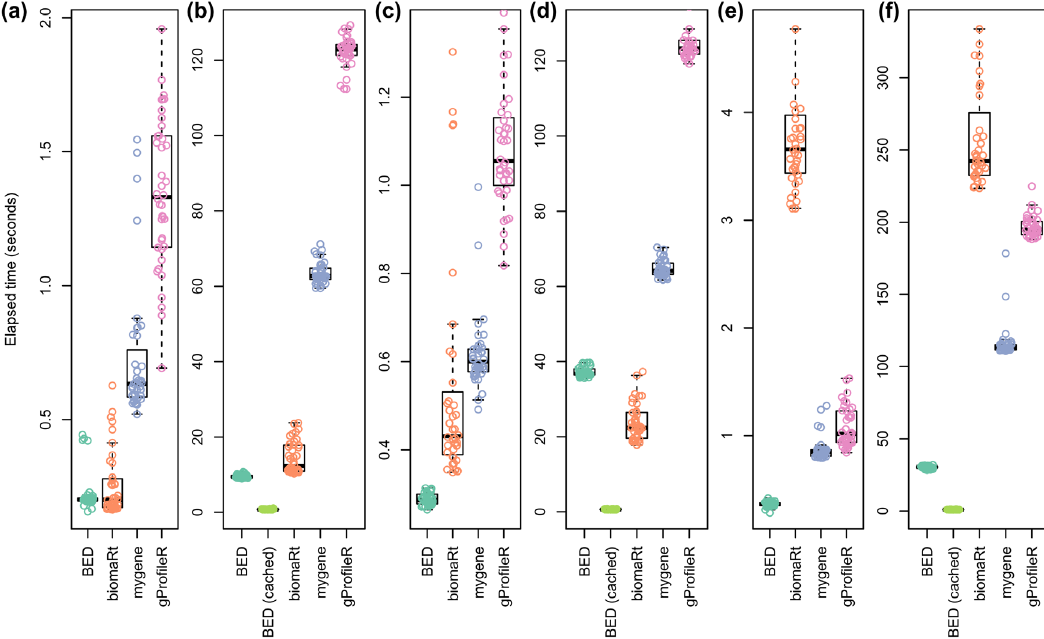
Figure 7. Comparison of the time taken to convert a set of randomly selected BE identifiers. Random selections of 100 or 20,000 identifiers have been executed 40 times before conversion by each considered tools. BED